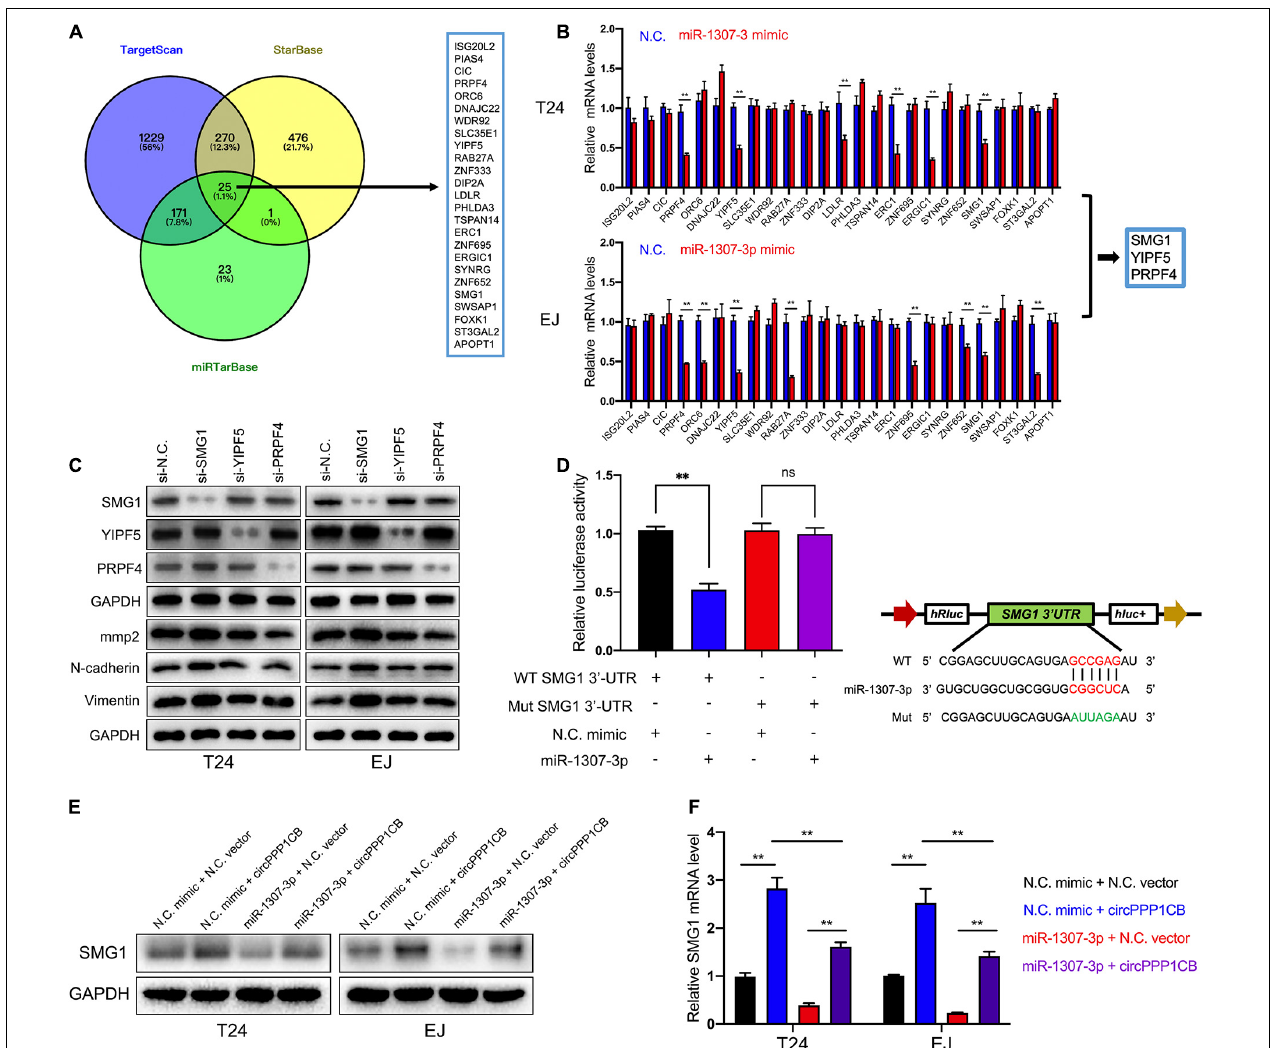
FIGURE 5 | SMG1 is directly targeted by miR-1307-3p. (A) Overlapping of target genes of miR-1307-3p in TargetScan, Starbase, and miRTarBase. (B) Twenty-five potential genes were detected in control or circPPP1CB knockdown cells, and SMG1, WDR92, and PRPF4 were downregulated in both T24 and EJ. (C) Only SMG1 could induce the alternations of EMT markers and MMP2. (D) Luciferase reporter assay verified the interaction between SMG1 3’-UTR and miR-1307-3p. (E,F) A negative correlation between miR-1307-3p and circPPP1CB at mRNA level and protein level. * p < 0.05, ** p < 0.01 vs. control group.